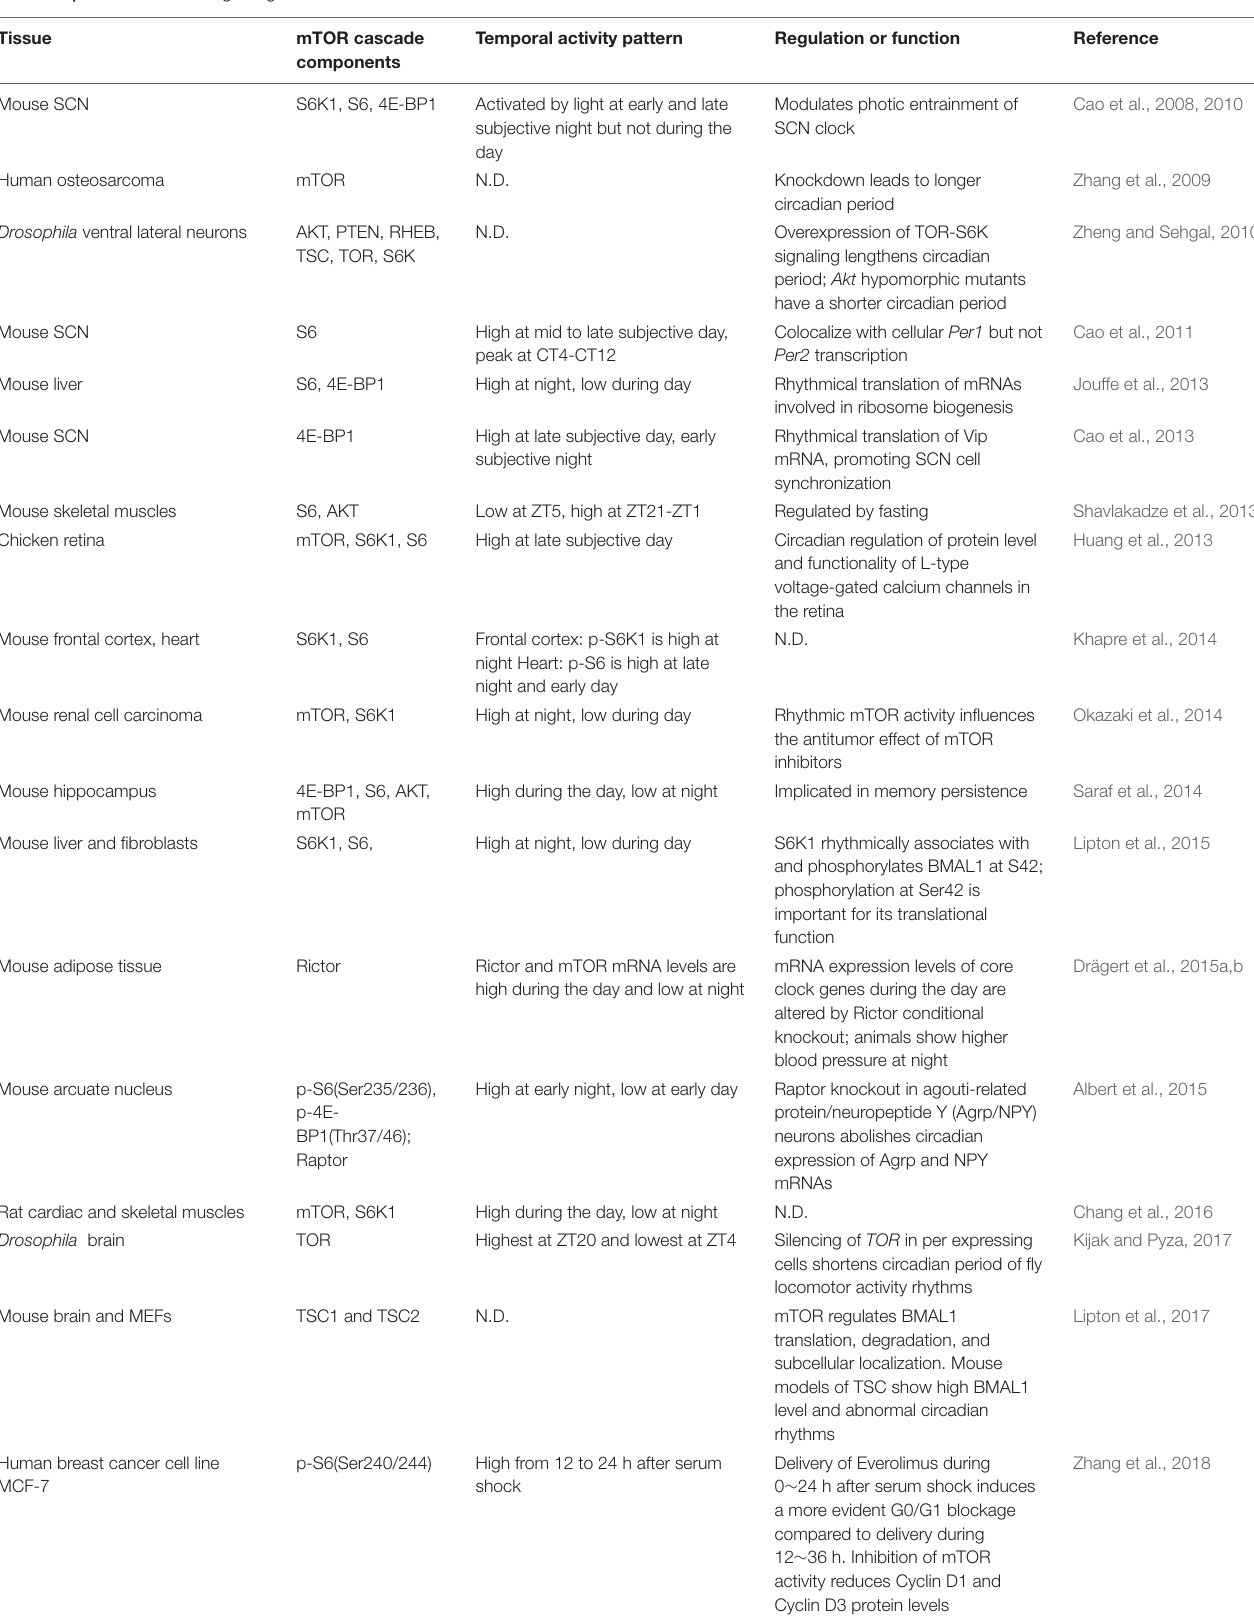
TABLE 1 | Circadian mTOR signaling in various